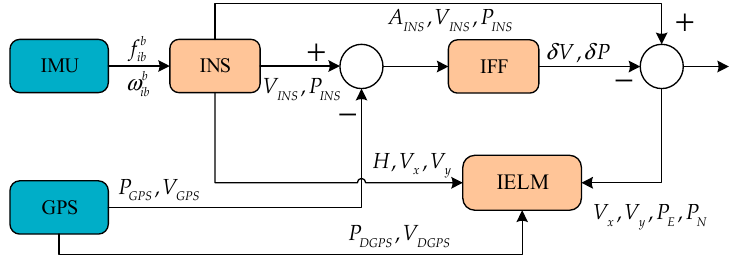
Figure 4. Training mode based on the improved extreme learning machine (IELM) when GPS data is available. IFF: improved fading filter.